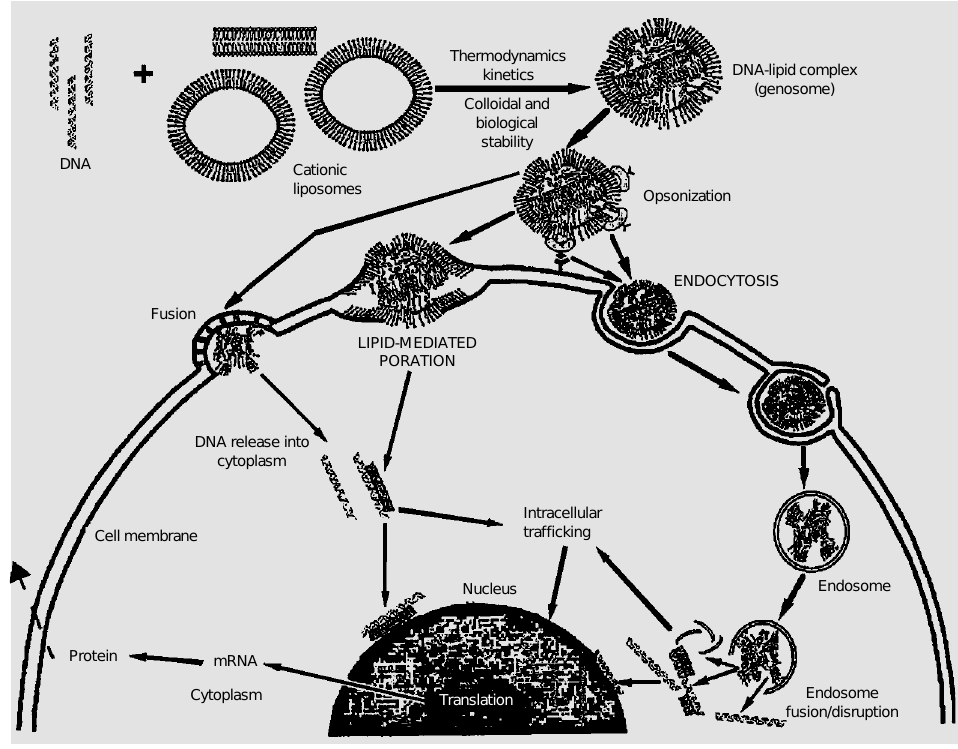
Figure 1. A hypothetical model of gene transfection. Three pos- sible methods of cell entry are indicated. Reprinted from Ref. 1, with